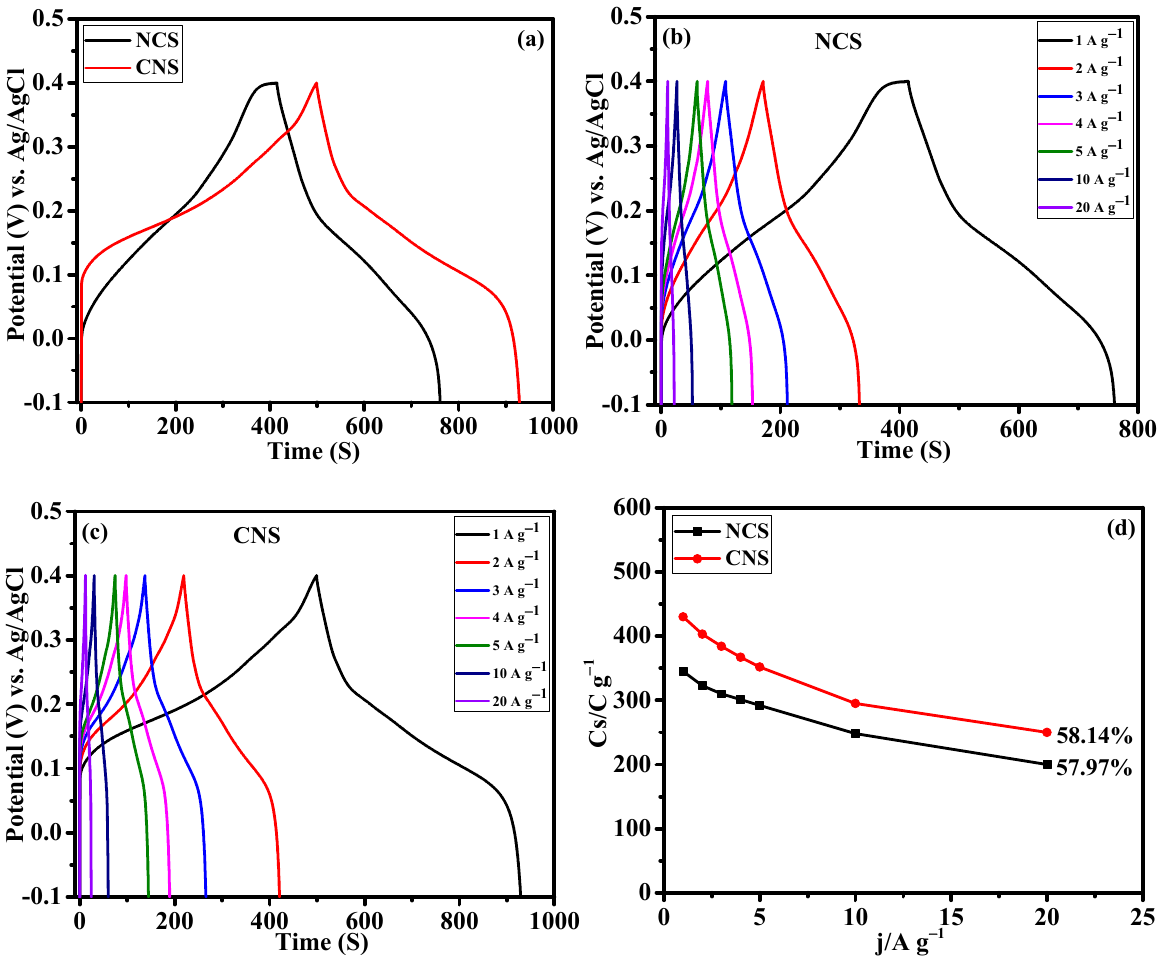
Figure 7. Galvanostatic charge discharge performance of NCS and CNS electrodes. ( a ) comparative GCD profile, ( b , c ) detailed GCD curves of NCS and CNS electrodes at different current densities, respectively. ( d ) The rate performance of NCS and CNS electrodes.